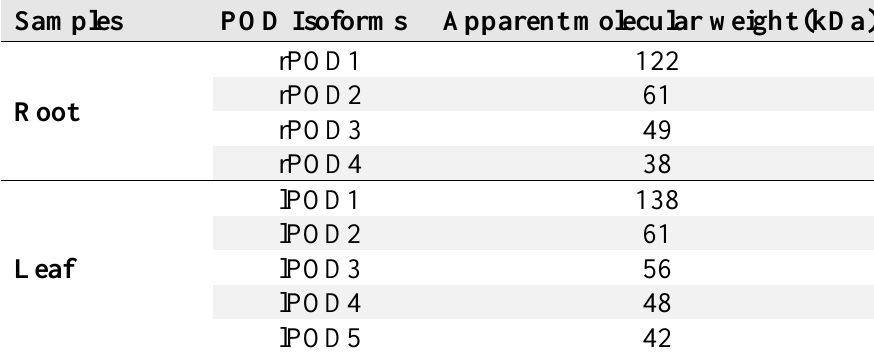
Table 1. Molecular weights POD isoforms detected with modified SDS electrophoresis in roots and leaves of R.